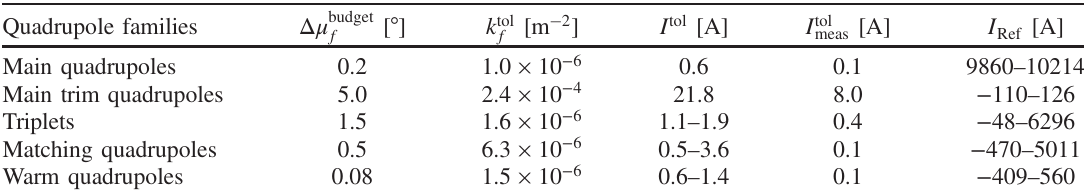
TABLE III. PcInterlock tolerances, k tol f and I tol , on quadrupole strength and currents operationally used in 2017 with β (cid:1) ¼ 40 cm and Δ μ budget ¼ 5 . 2 ° [see Eq. (4)]. Quadrupole families Main quadrupoles Main trim quadrupoles